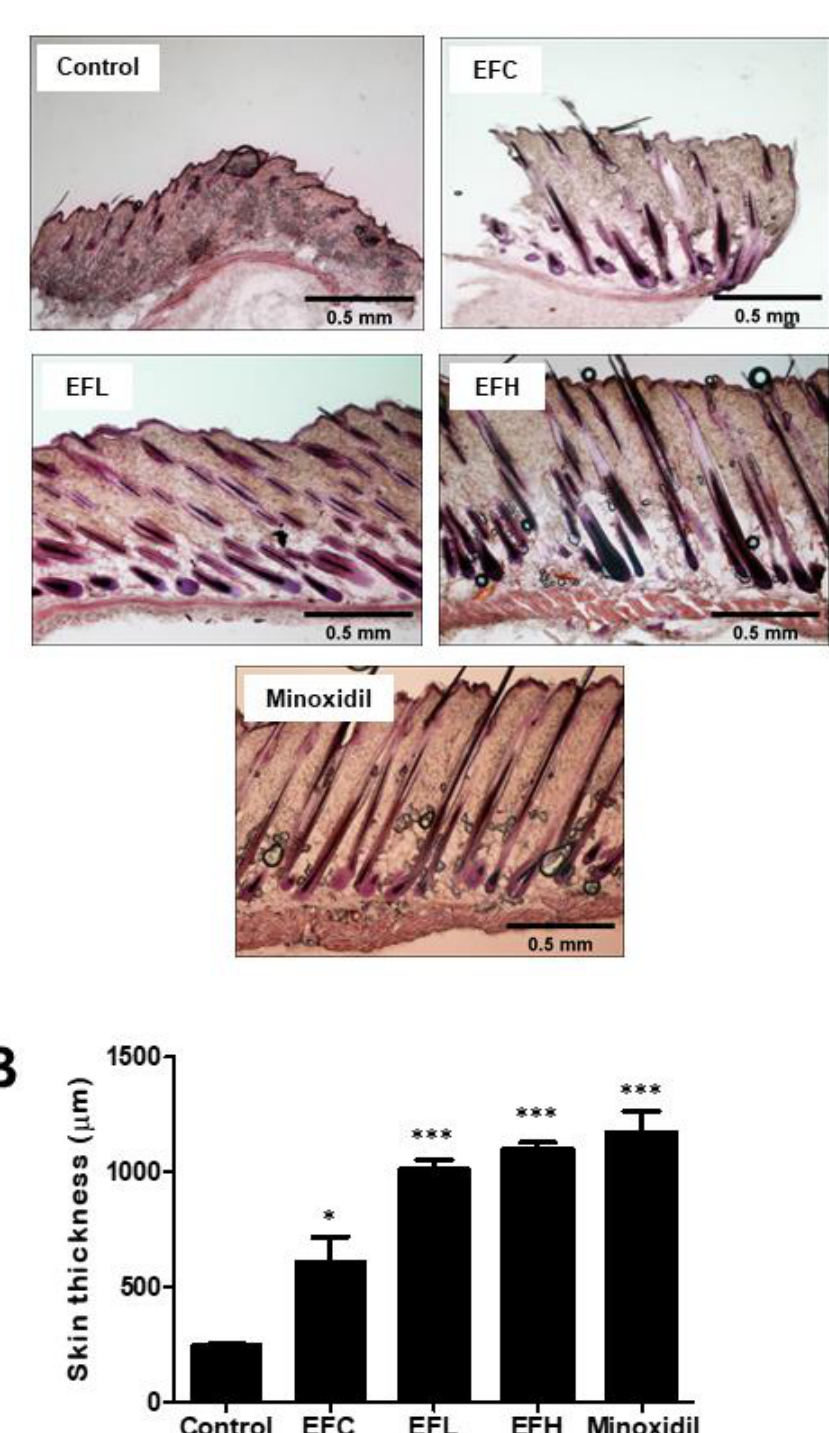
Figure 3. The effect of hair regrowth treatments on C57BL/6 male mice skin as assessed by hematoxylin and eosin (H&E) staining. ( A ) Longitudinal sections of the dorsal skins for each group by H&E staining. ( B ) The skin thickness in the section for each group. Data are expressed as mean ± SD ( n = 3). * p < 0.05, *** p < 0.001 versus control.